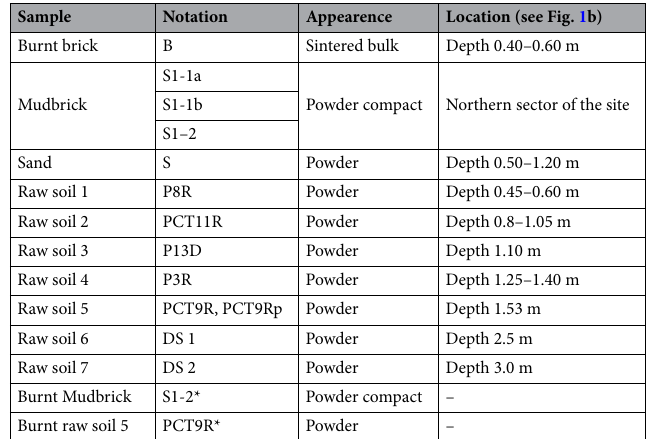
Table 1. Samples, notation, appearance, and excavation details. PCT9Rp was extracted at approximately the same location and depth as PCT9R; (*) as-excavated powder samples ignited in laboratory at 880 °C in air with a heating rate of 200 °C/h, and a dwell time of 1 h. Two categories of soils were defined: low depth soils (< 1.53 m) and high depth soils (2.5 and 3